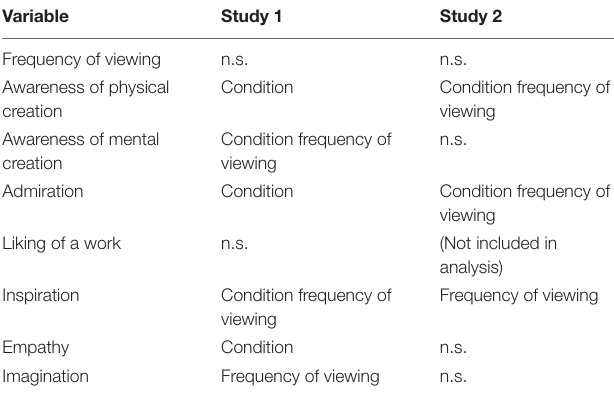
TABLE 5 | Comparison of results of Likert scales in Studies 1 and 2.